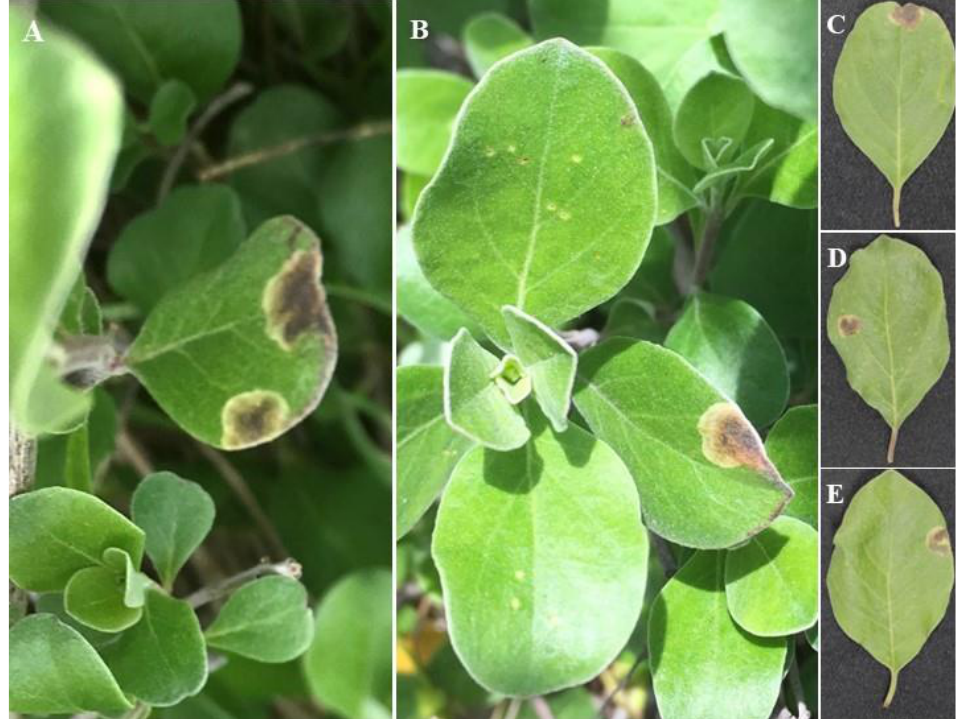
Figure 1. Disease symptoms on leaves of beach vitex plants. Natural disease symptoms ( A , B ). Harvested individual leaves showing symptoms ( C – E ).